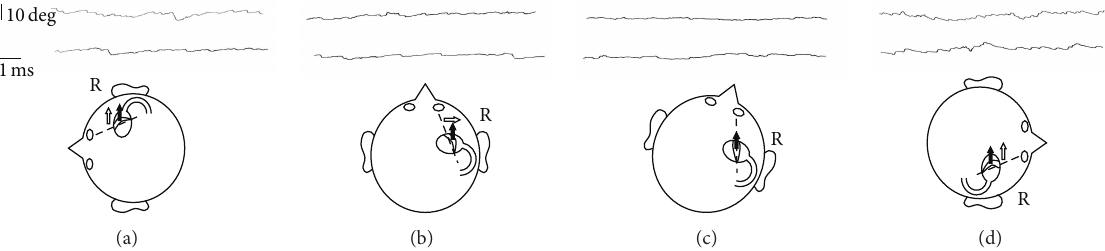
Figure 1: Electronystagmogram before surgery. Upper waves indicate eye position since turning head position. Lower waves indicate those one minute after maintaining the head position. The schemas indicate head positions and direction of copular deviations (outlined arrows). Filled arrows indicate direction of antigravitational vector and dotted lines indicate neutral position of cupula. (a) Left side down position. Antigravitational force deviates cupula of the right ear to the ampullofugal direction thus left beating nystagmus was observed. (b) Supine position. As the long axis of cupula is constitutionally out of alignment with anterior-posterior axis, cupula deviates to the ampullofugal direction and left beating nystagmus was also observed. (c) Approximately 30 degrees turn to right position. The long axis of cupula conforms with the antigravitational vector; thus cupula remains stationary and any nystagmus was not observed (neutral point). (d) Right side down position. Antigravitational force deviates cupula to the ampullopetal direction; thus right beating nystagmus was observed.